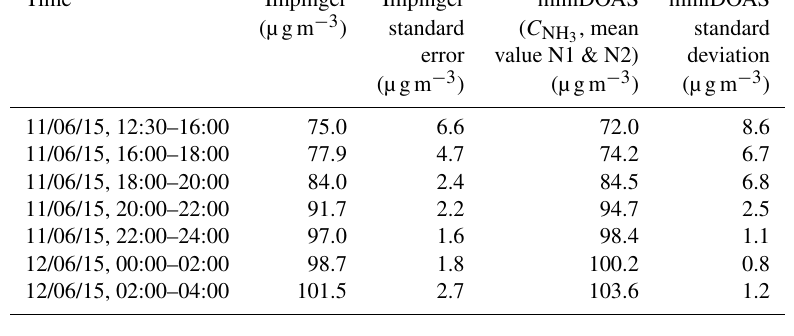
Table 2. NH 3 concentration comparison between impinger systems and the miniDOAS systems N1 and N2 at the HAFL auditorium. Time